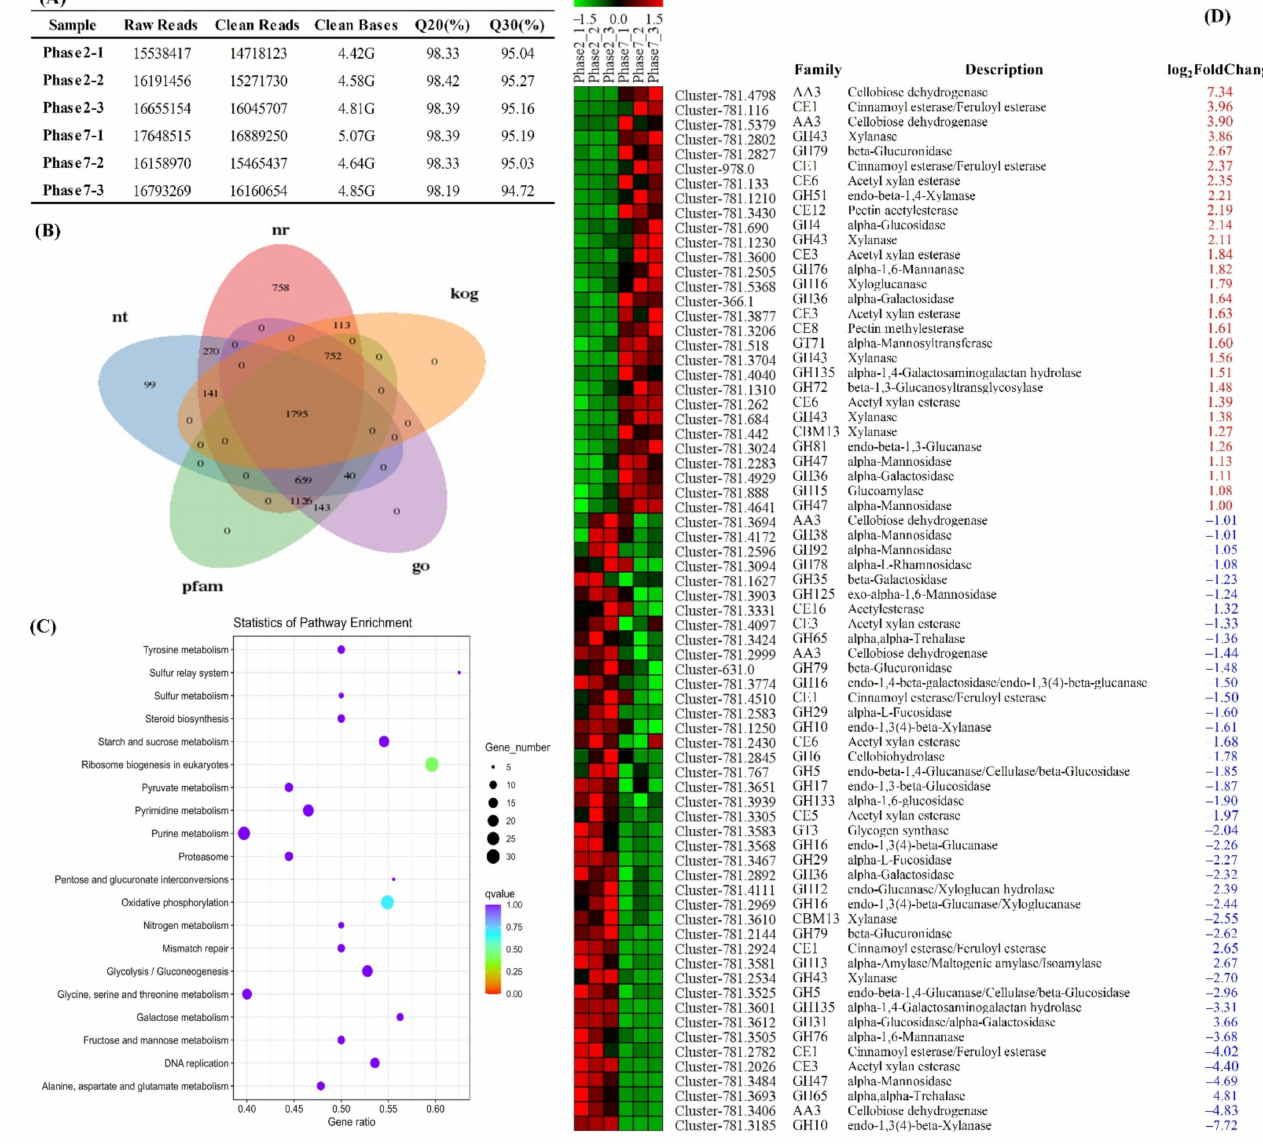
Figure 4. Functional annotation and classification of unigenes in transcriptomics analysis. ( A ) Sum- mary of transcriptome sequencing data quality, ( B ) Venn diagram illustrating shared and unique unigenes annotated in public database, ( C ) KEGG enrichment analysis of all the identified DEGs and ( D ) CAZymes annotation of DEGs. The red and blue numbers in Figure 4D represented the up-regulated and down-regulated multiples of these identified CAZymes,